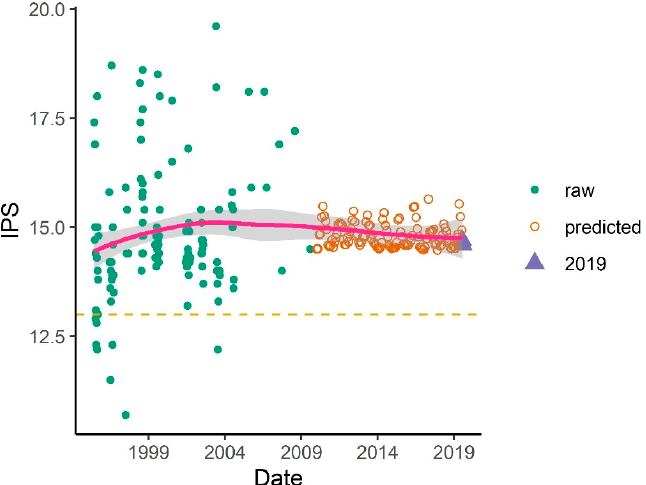
Figure 15. Calculation of IPS values based on the composition of diatom assemblages on deployed and natural reeds at c5 and c6 sampling points of the Cikola tributary system and calculations using the model for the missing periods in the function of water discharge and LOESS curve is fitted to them.